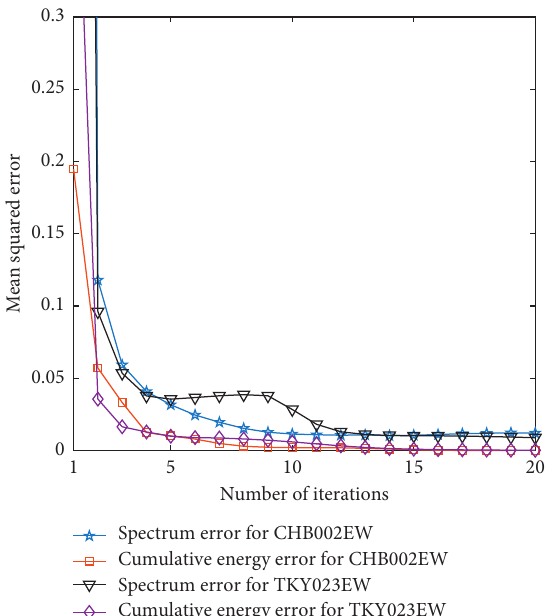
Figure 17: Mean squared error for each iteration.